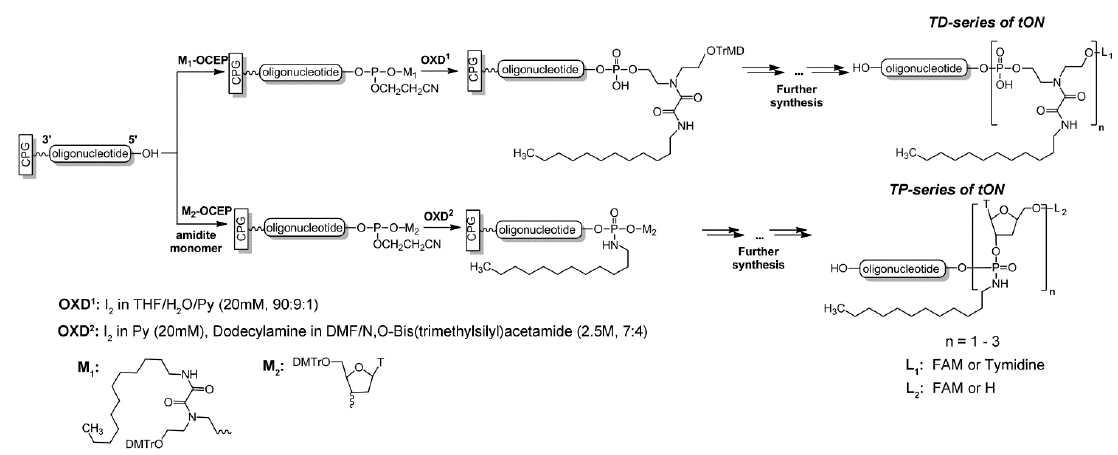
Figure 2. Scheme of synthesis of transport oligonucleotides.